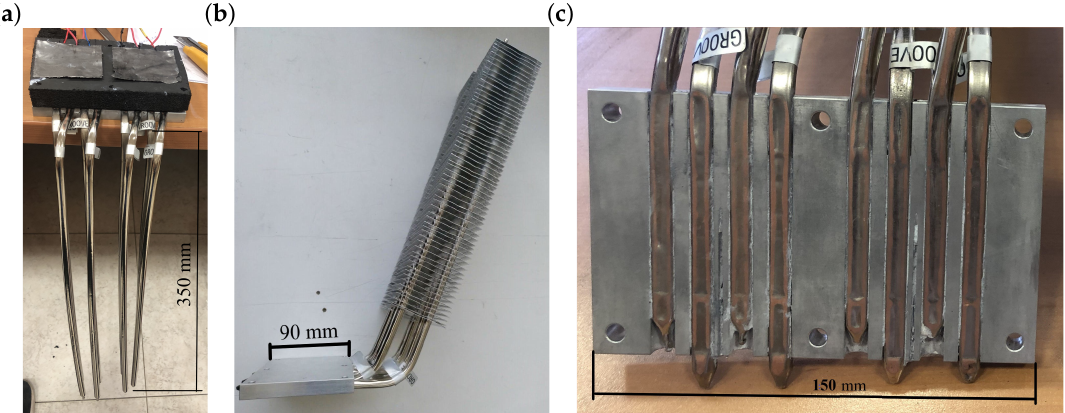
Figure 2. ( a ) Hot side heat exchanger. ( b ) Cold side heat exchanger. ( c ) Detail of the fitting between the heat pipe tubes and the aluminum